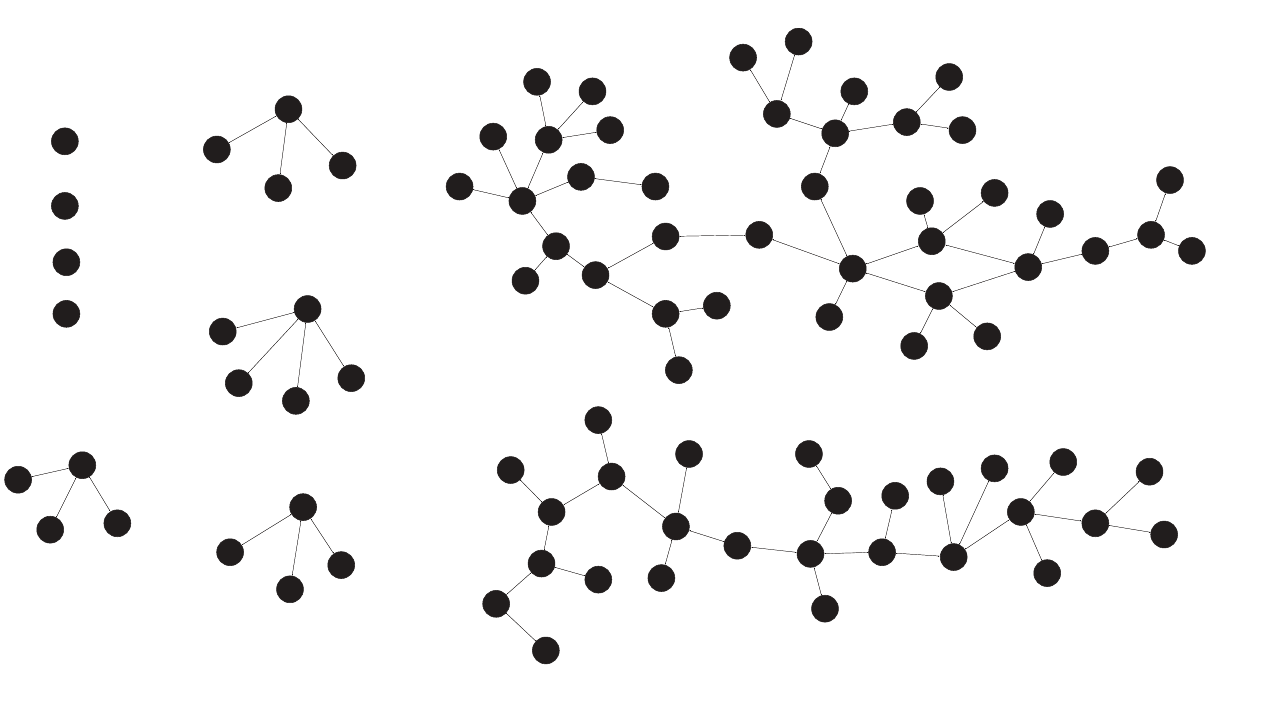
Fig 9. Interaction relations among all cooperators in the stationary regime of evolutionary dynamics under upper-bound W = 4. Defect temptation is set to b = 1.01.